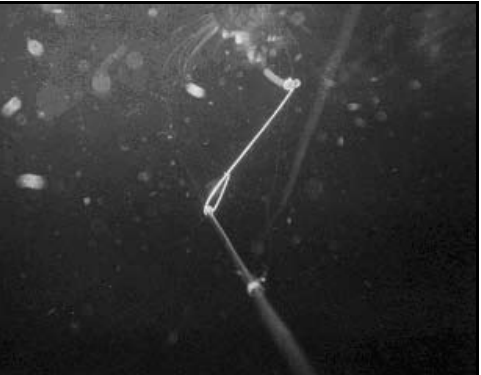
Fig. 7 . Photo from camera trap; grey seal taking bait (top of